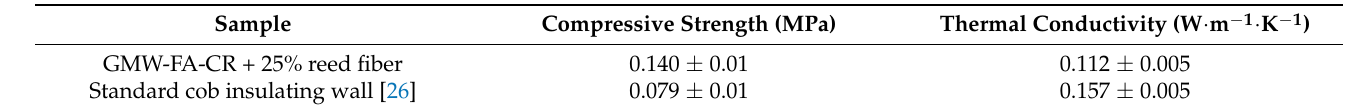
Table 11. Physical Properties of the Thermal Insulating Materials Based on GWM-FA-CR and 25% Reed Fiber after 28 Days of Curing Compared to Those of Standard Cob Insulating Building Mate- rials from the Literature.